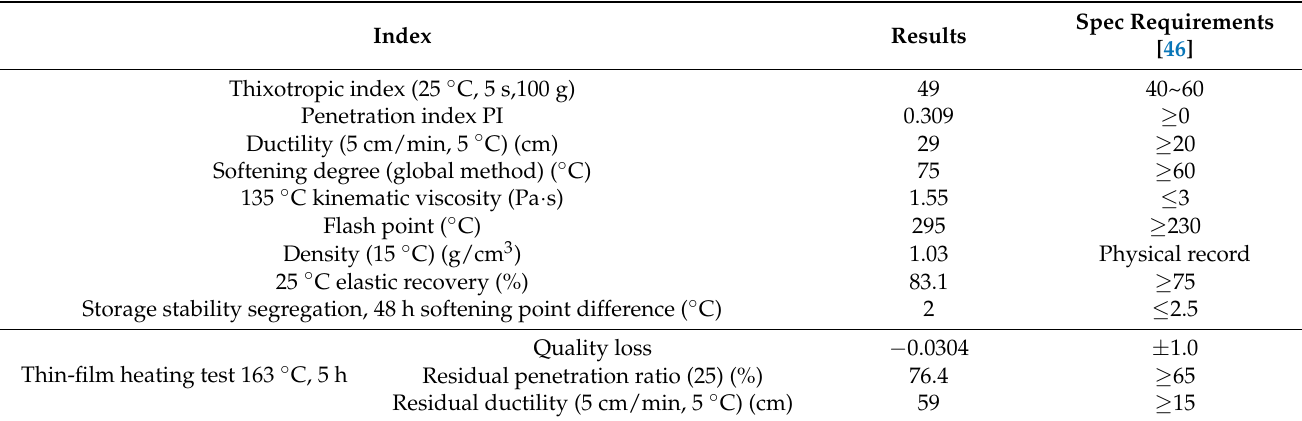
Table 5. Technical indices of the